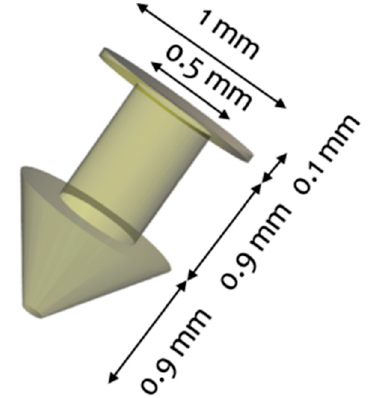
Figure 1. 3D design of the punctal plug.